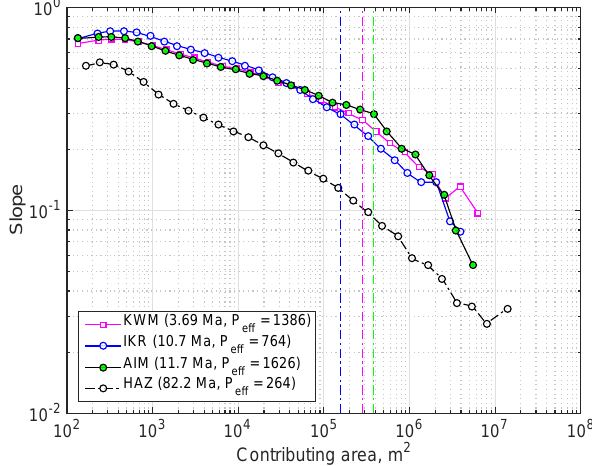
Figure 12. Mean slope–area relationship for the catchments with tectonic uplift of 1000m in the Quaternary. Vertical dashed lines represent visually determined larger inflection points for KWM (2 . 8 × 10 5 m 2 , pink), IKR (1 . 5 × 10 5 m 2 , deep blue), and AIM (3 . 7 × 10 4 m 2 , green),